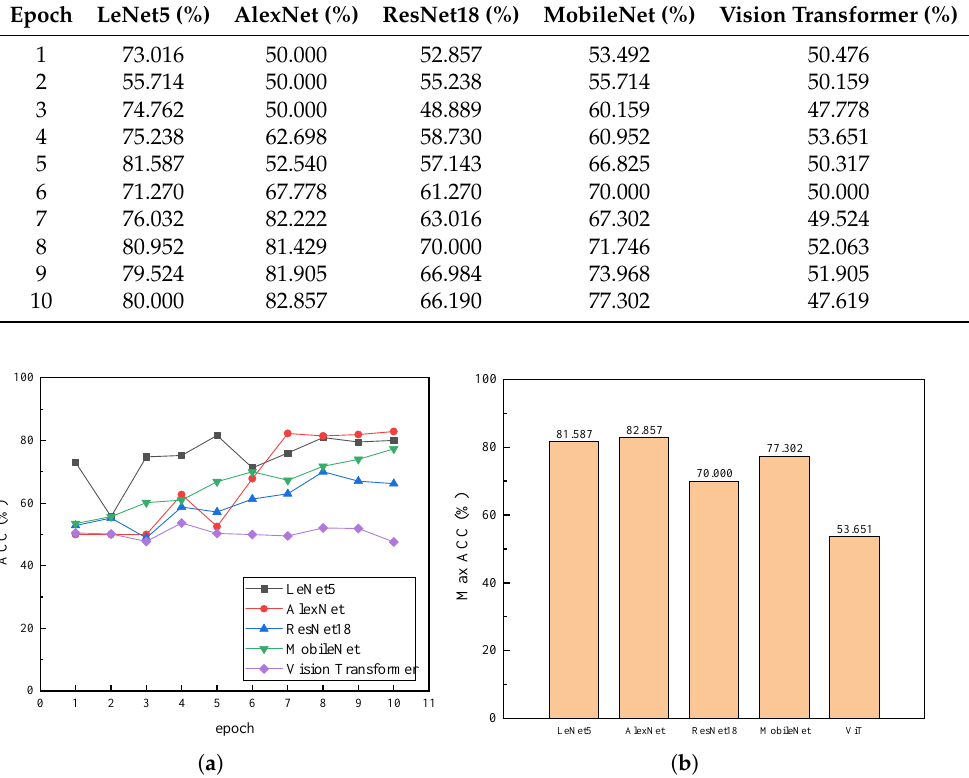
Figure 9. Comparison of accuracy after data augmentation and after GPU loading. ( a ) Comparison of accuracy of each model after data augmentation and after GPU loading. ( b ) Histogram comparing the highest accuracy of each model after data augmentation and after GPU